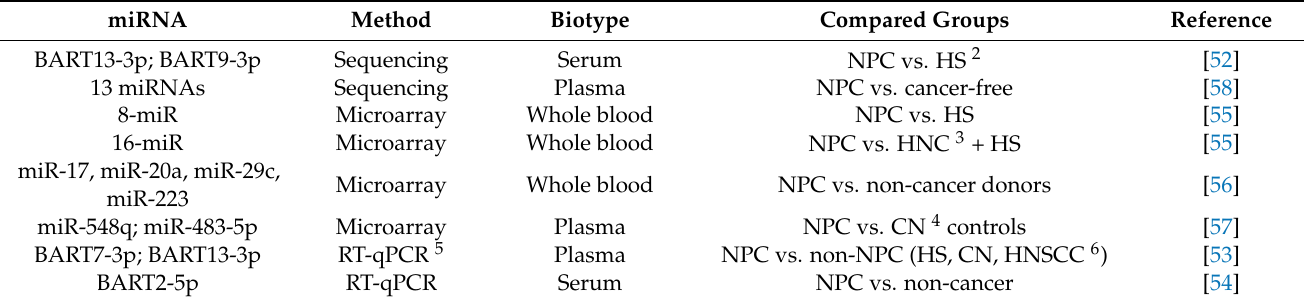
Table 1. Circulating miRNAs and miRNA signatures useful for NPC 1